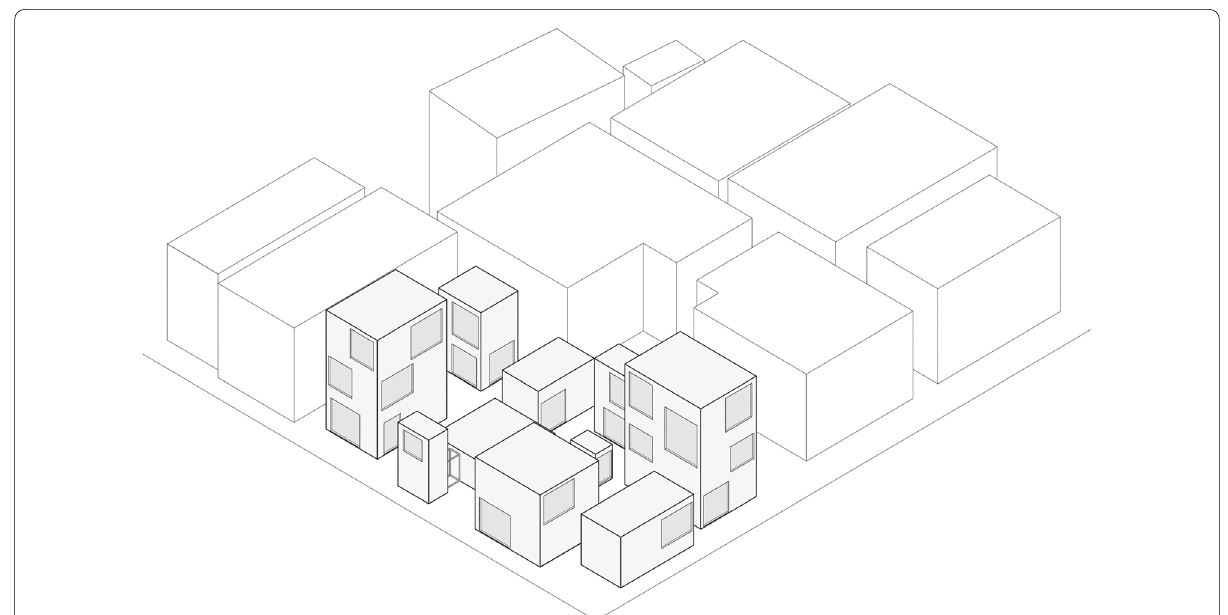
Fig. 4 Moriyama House , R. Nishizawa, Tokyo, 2005. Light gray: the community of